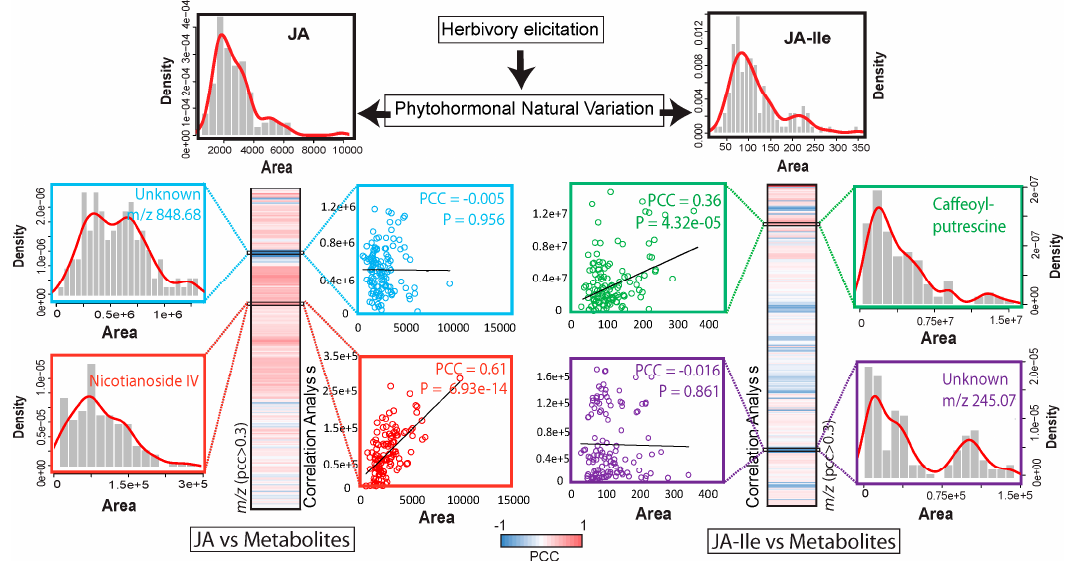
Figure 2. Population-level quantitative variations in herbivore-elicited metabolites only partly overlaps with jasmonate accumulation polymorphisms. The figure is modified from [40]. Density distribution plots of JA and JA-Ile (x axis, area of intensities and y axis, fitted density with histogram) (123 samples) illustrate the patterns of natural variation in JA and JA-Ile levels as analyzed by targeted LC-MS/MS/MS workflows for leaf samples collected 1 h after simulated herbivory from glasshouse-grown accessions of N. attenuata . Heatmaps of pairwise Pearson correlation coefficients (PCCs) (only PCCs with either JA or JA-Ile >0.3 are shown) illustrate significant co-regulation patterns between metabolite relative levels and JA and JA-Ile levels. Examples of known and unknown metabolites are depicted in density plots and scatter plots (colored with different color boxes accordingly). The herbivory-inducible defense compound, Nicotianoside IV, correlates significantly with JA whereas N-caffeoylputrescine shows significant correlation with JA-Ile. Unknown m/z 848.68 and 245.07 exhibit poor correlations with JA or JA-Ile. Discovering the identity of these and other unknown compounds exhibiting significant correlation scores with JA and JA-Ile levels will be the topic of future research to uncover novel defensive metabolites in N. attenuata .